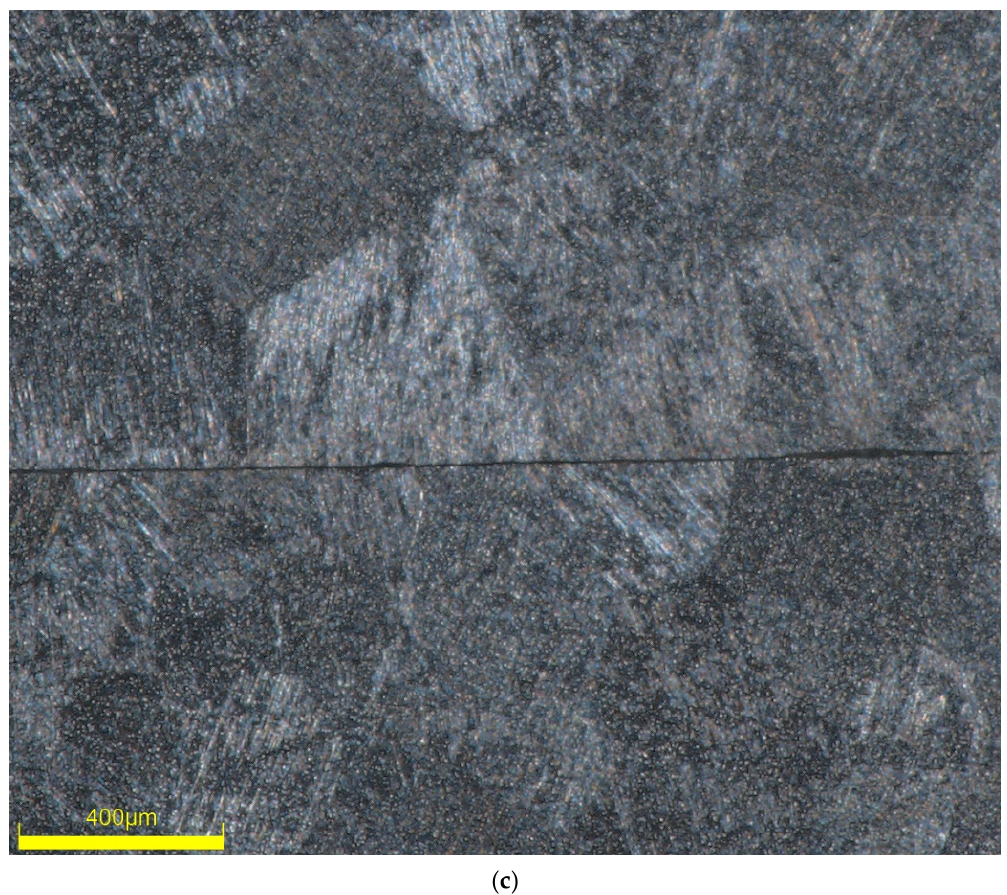
Figure 17. Microstructure of titanium sheet ( a ) and Type 2 ( b ) and Type 3 ( c ) welded samples obtained by microplasma welding at ×145 magnification.